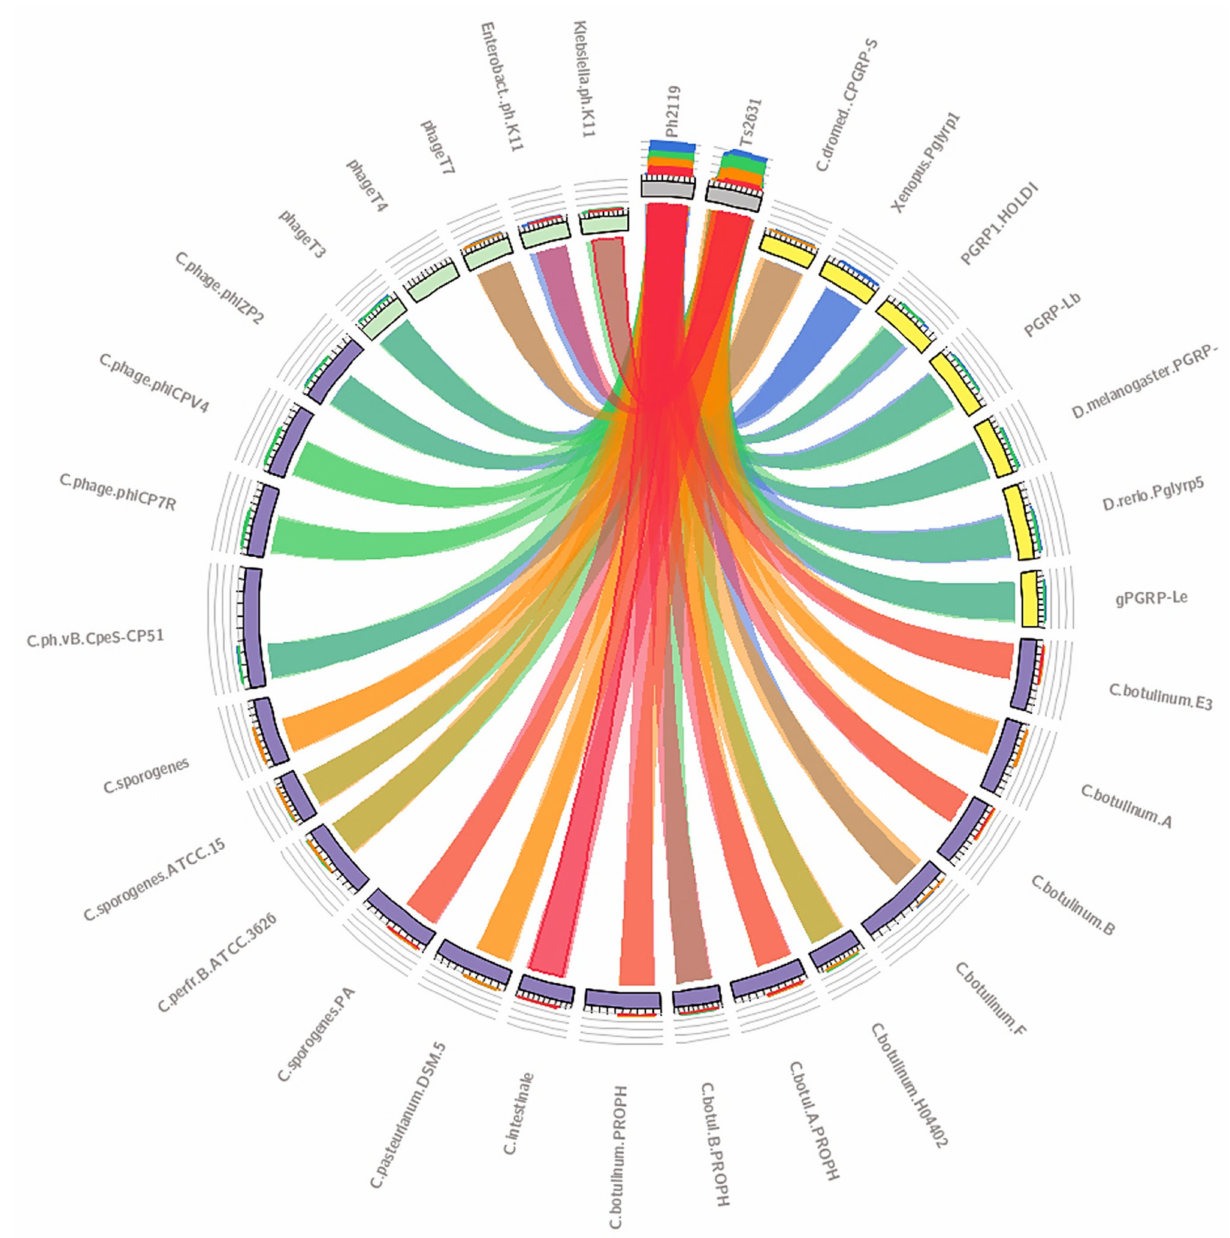
Figure 1. The similarity analysis of thermostable endolysins Ph2119 and Ts2631 compared to phage and bacterial lytic enzymes including Clostridium enzymes and eukaryotic proteins recognizing peptidoglycan (PGRPs), visualized using Circoletto software [33]. The Basic Local Alignment Search Tool (BLAST) sequence comparison results are represented in four quartiles, each shown in a different color pattern. Red ribbons reflect the highest score, corresponding to 33–34% amino acid sequence identity, orange and green indicate medium scores, and blue indicates the lowest percentage of identity (26%). The width of the ribbons represents alignment length. Original dataset with the protein amino acid sequences and their respective GenBank or Protein Data Bank (PDB) accessions numbers and the BLAST results with E values are available as Supplementary Materials S1 and